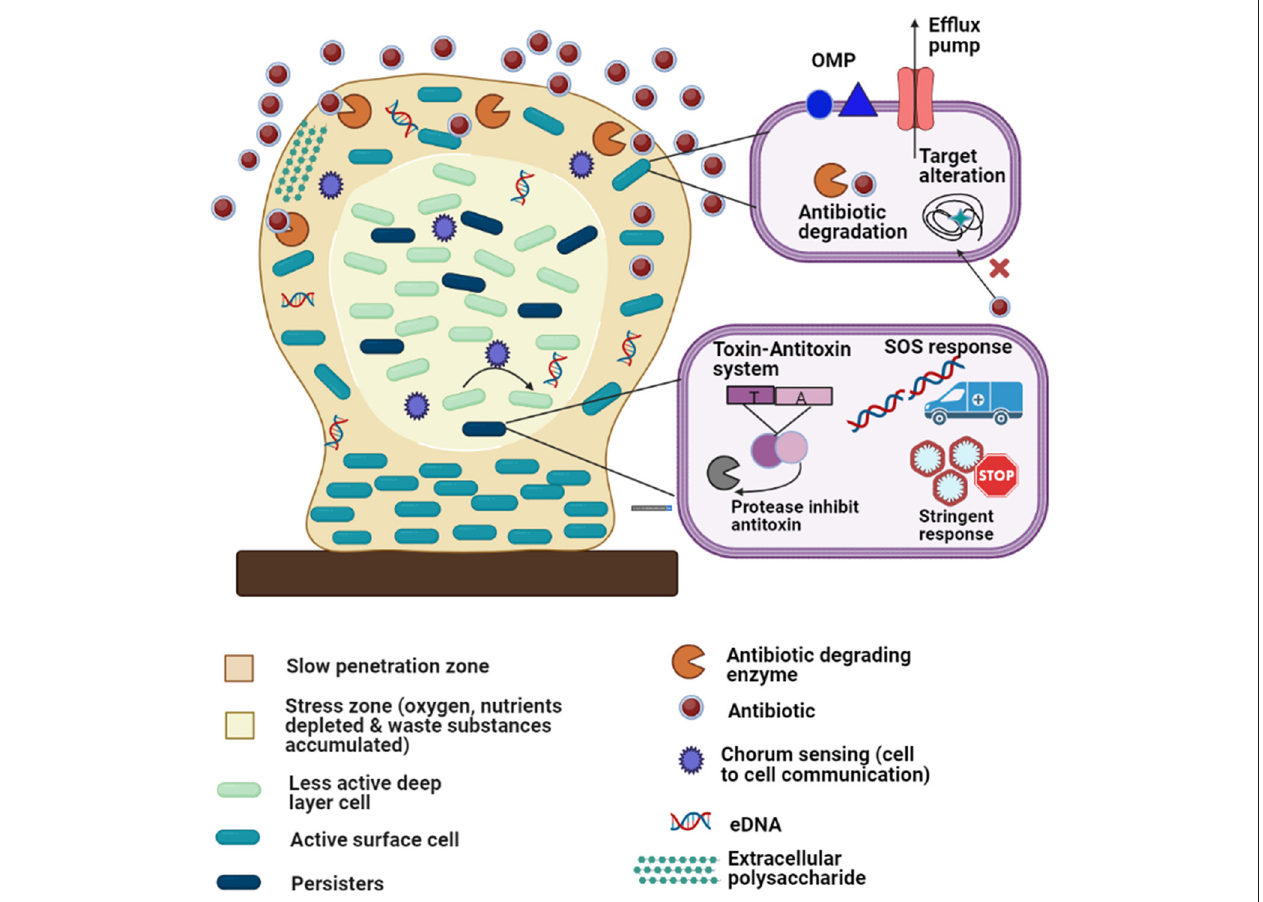
FIGURE 4 | Diagrammatic representation of the antibiotic resistance mechanisms of biofilm-embedded bacterial cells: The biofilm is attached to a biotic or abiotic surface (brown rectangle). Development of persister cells (dark green) and less active deep layer cells (light green) in the stress zone (the core of the biofilm, light cream color) where fewer nutrients are available. The various resistant mechanisms depicted in the figure are as follows: (1) matrix exopolysaccharides cause slow penetration of antibiotics; (2) extracellular DNA (eDNA); (3) multidrug efflux pumps; (4) outer membrane protein; (5) antibiotic degrading enzymes and target modifications (6) quorum sensing; (7) stress responses (oxidative stress response, stringent response, etc.); (8) toxin-antitoxin system and (9) SOS